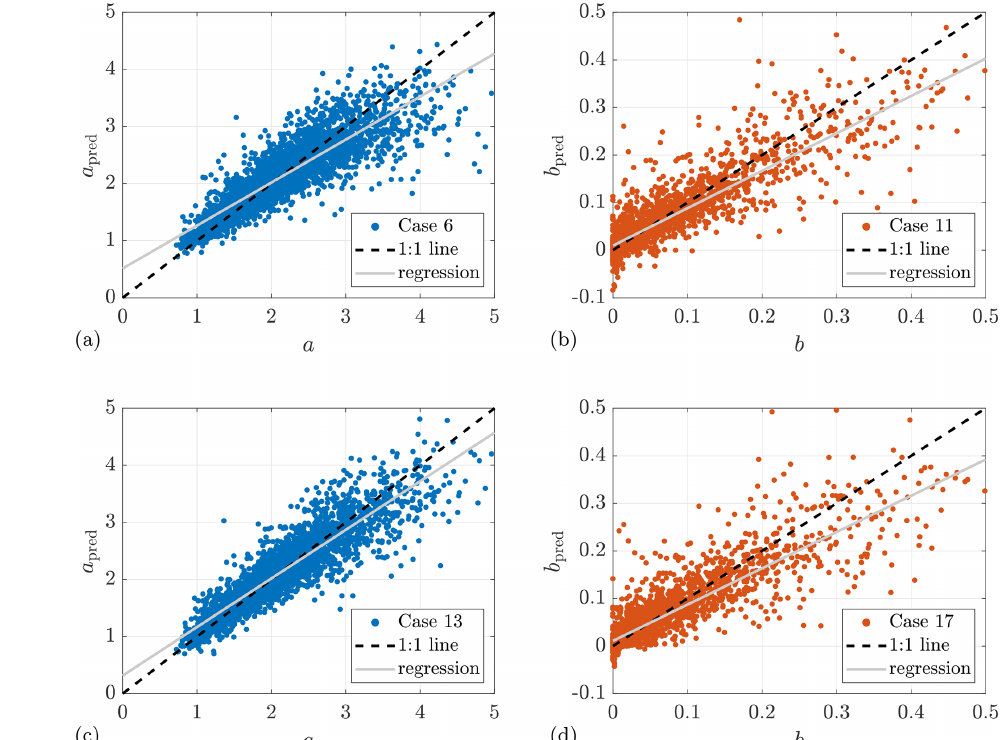
Figure 11. Comparison of prediction performance of models using lidar data and sonic data from Lidar Complex. (a, b) Lidar data. (c, d) Sonic data. The subscript “pred” indicates the predicted values.